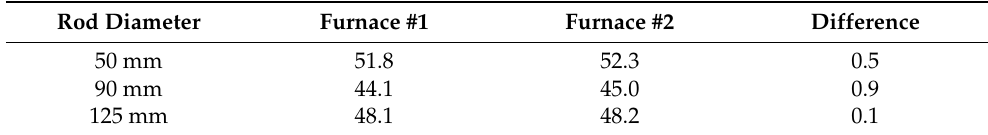
Table 6. Boundary layer thickness deviation